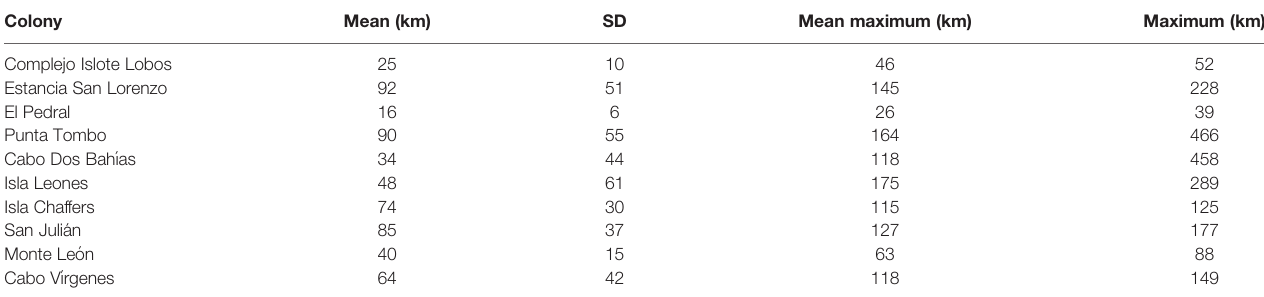
TABLE 3 | Foraging distances for Magellanic penguins breeding at 10 colonies in Argentina.